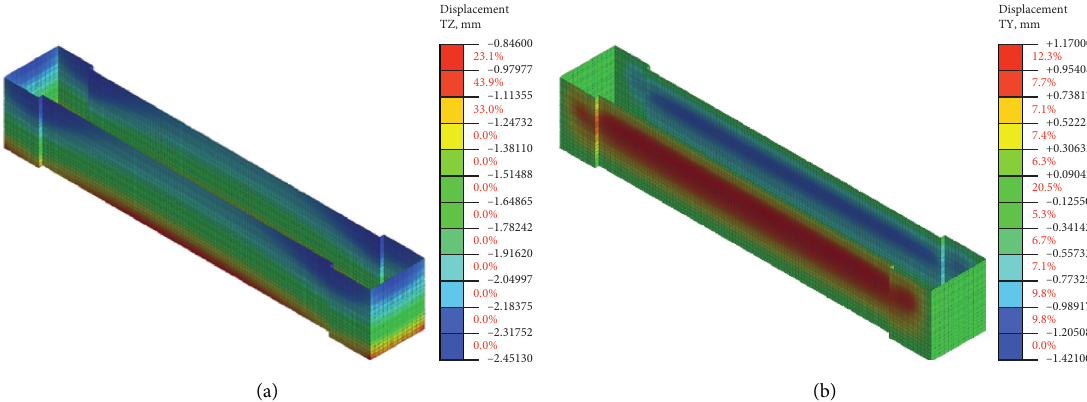
Figure 15: Displacement diagram of the diaphragm wall after grouting reinforcement. (a) Settlement diagram. (b) Horizontal displacement diagram.